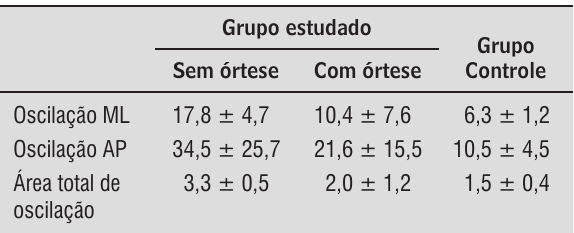
Tabela 2 - Oscilação do COP do GE sem e com órtese e do